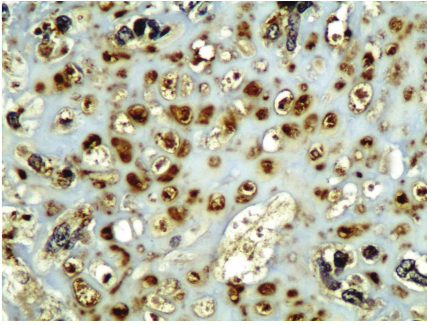
Figure 7: Anaplastic large bizarre cells amidst malignant pleomor- phic cells. H&E: × 200.